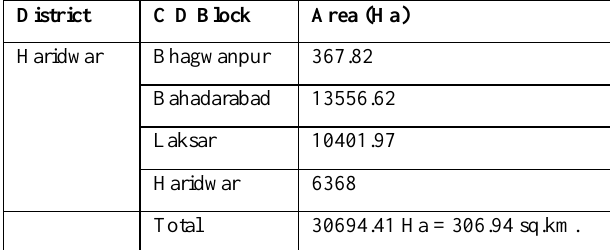
Table 2 : Area of blocks included in JJCR ESZ